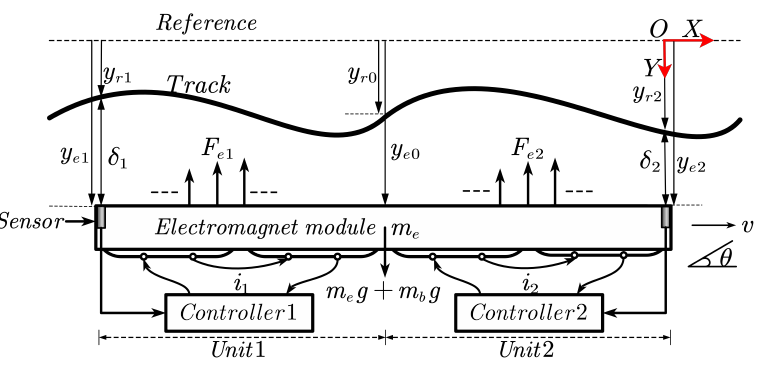
Figure 1. Vertical dynamic model of the electromagnet module and the